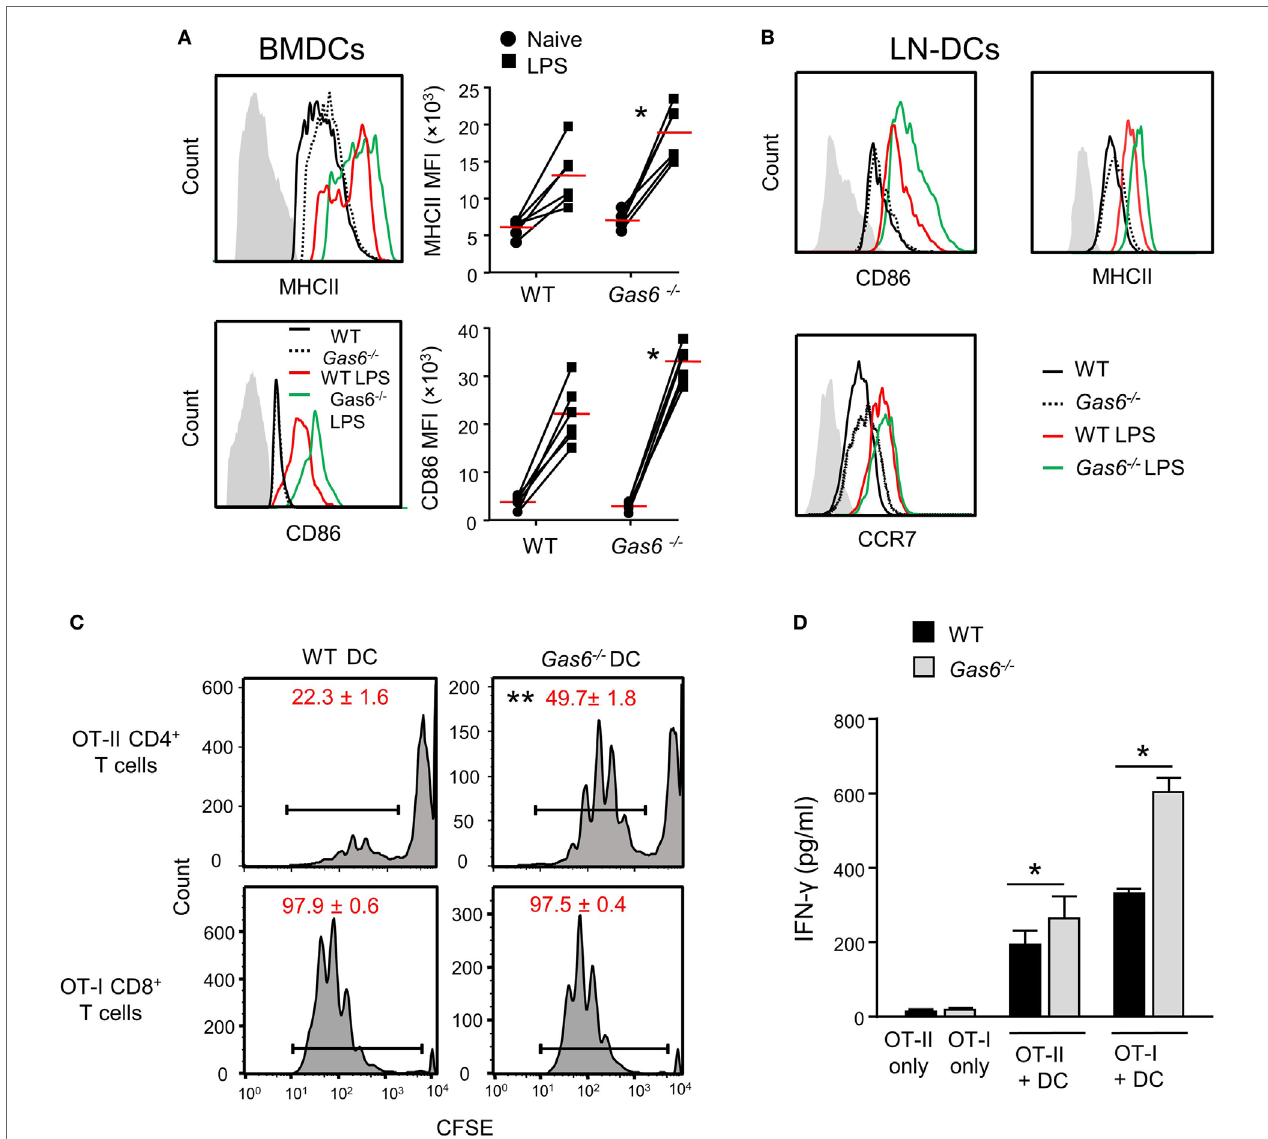
FigUre 7 | Growth arrest-specific 6 (GAS6) inhibits dendritic cell (DC) maturation and limits T-cell activation by DCs. (a) BMDCs generated from WT and Gas6 − / − mice were stimulated with LPS for 24 h. Representative FACS histograms and graphs demonstrating the expression and mean florescence intensity (MFI) of MHCII (top) and CD86 (bottom) on BMDCs, respectively. Gray histograms represent staining on MHC-negative cells in the culture. (B) DCs purified from cervical lymph nodes (LNs) of Gas6 − / − and WT mice were stimulated with LPS for 24 h. Representative FACS plots demonstrating the expression of CD86, MHCII, and CCR7 are presented. (c,D) DCs enriched from cervical LNs of Gas6 − / − and WT mice were stimulated with LPS and OVA peptides and then co-cultured with naive CFSE-labeled OT-II CD4 + T cells or OT-I CD8 + T cells. (c) Three days post-stimulation the dilution in CFSE levels on the T cells was analyzed by flow cytometry, representative FACS histograms are presented, numbers indicate the mean of three repeats per group ± SEM. (D) Bar graphs show the concentrations of IFN- γ secreted to the supernatant by activated CD8 + T cells and represent the mean of four repeats per group ± SEM. Representative data of one out of two independent experiments is